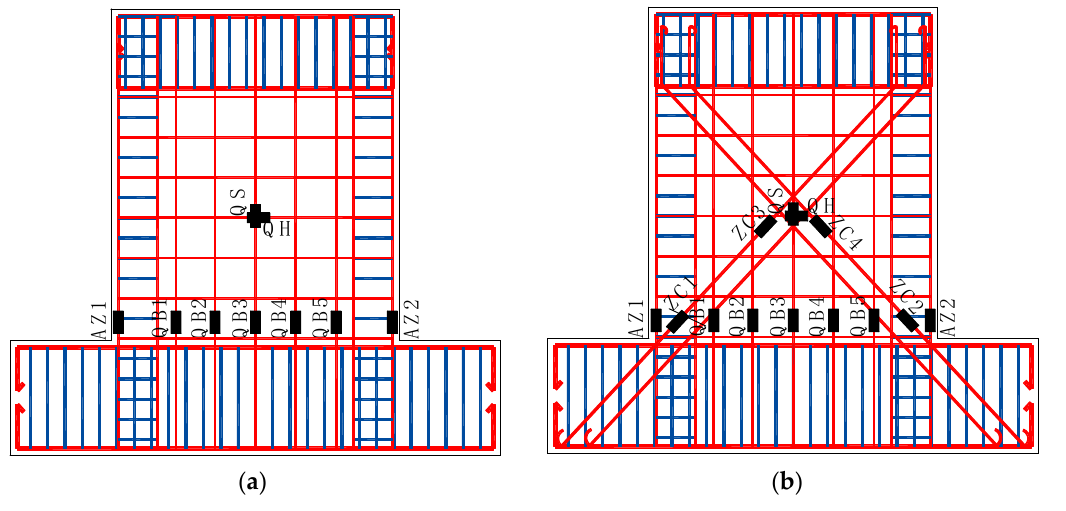
Figure 15. The location and numbering of the strain gauges. ( a ) Specimens W1, W2, W3, W4 and W5; ( b ) Specimen W8. Table 7. Horizontal loads and cycle number of loading when reaching yield strain.